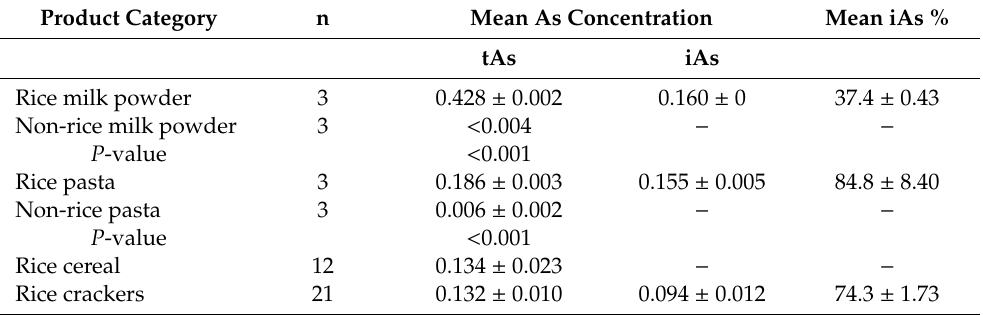
Table 2. Total arsenic (tAs), inorganic arsenic (iAs) concentrations (mg kg − 1 f.w.) and the proportion of iAs in rice-based infant foods on a fresh weight (f.w.) basis (values are mean ± standard error).